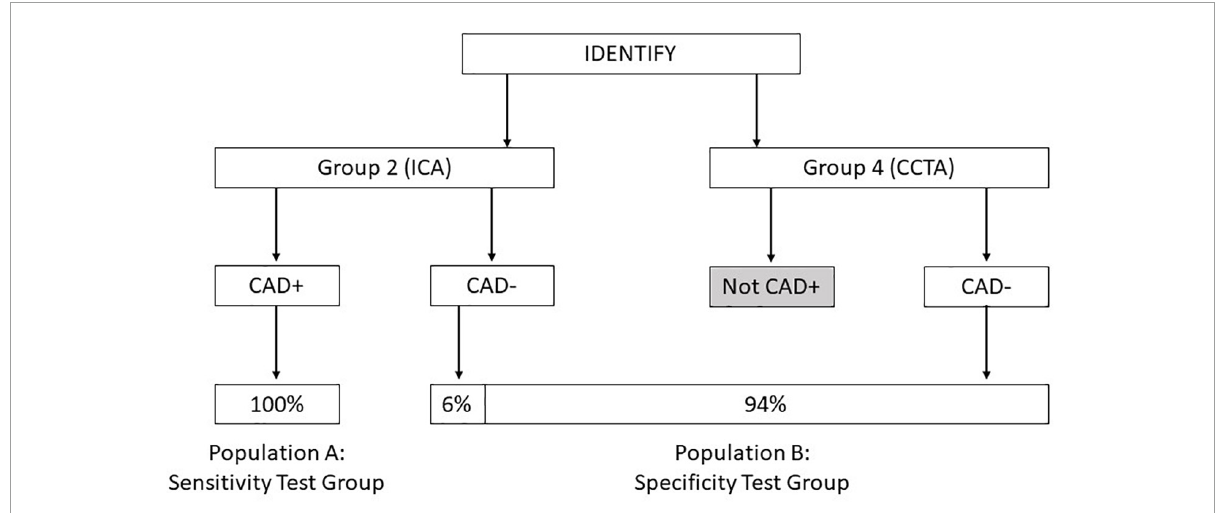
FIGURE1 Diagram showing the composition of population A: Sensitivity test group and population B: Specificity test group derived from the IDENTIFY clinical study.